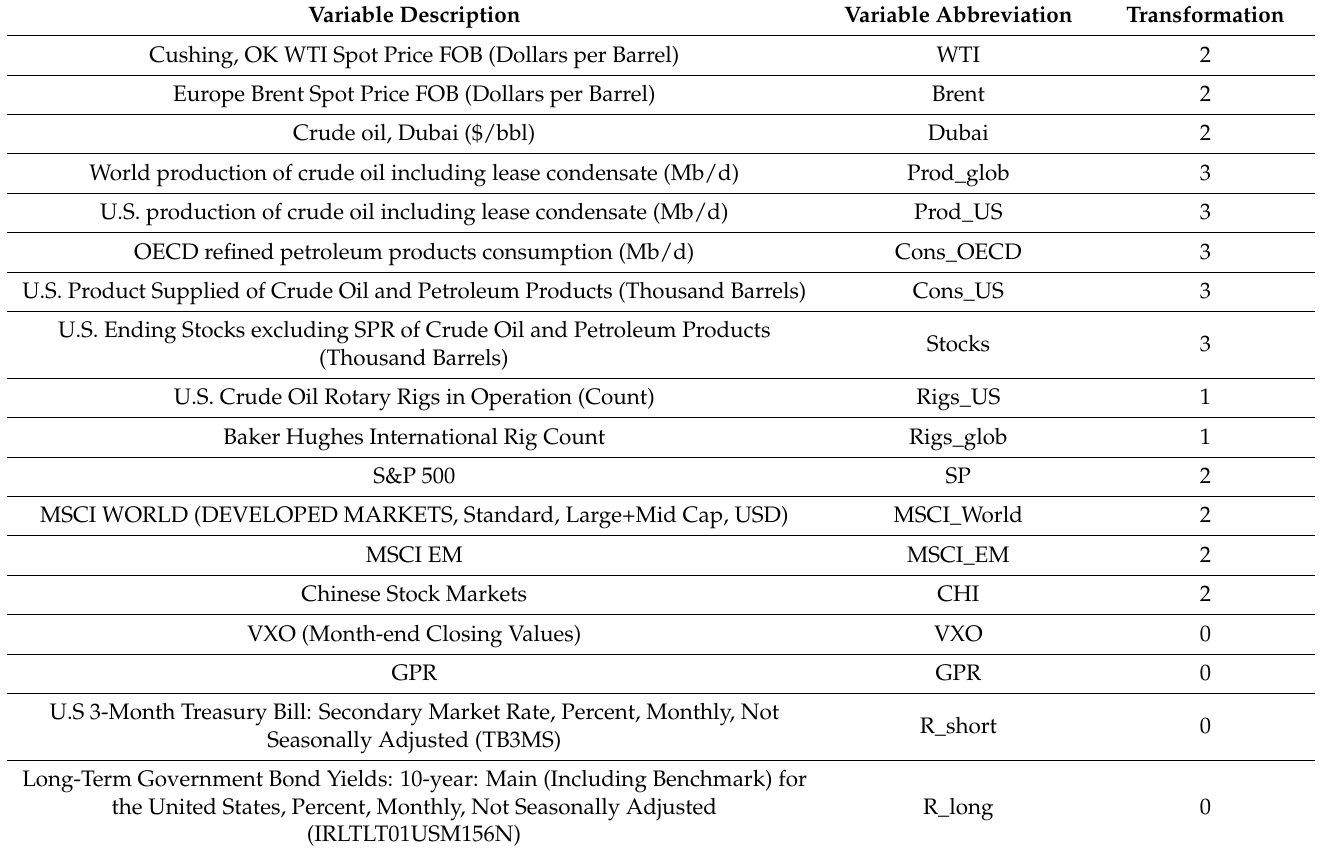
Table 1. Variables used in this